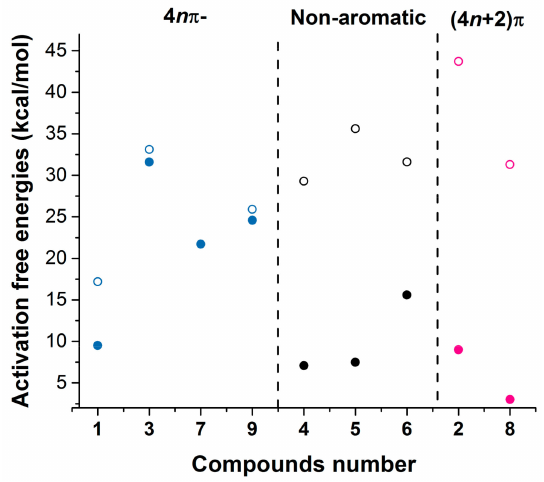
Figure 10. Activation free energies (kcal/mol) of all compounds 1 – 9 at the (U)B3LYP/6-311G(d,p) level in the S 0 (unfilled circles) and T 1 (filled circles)